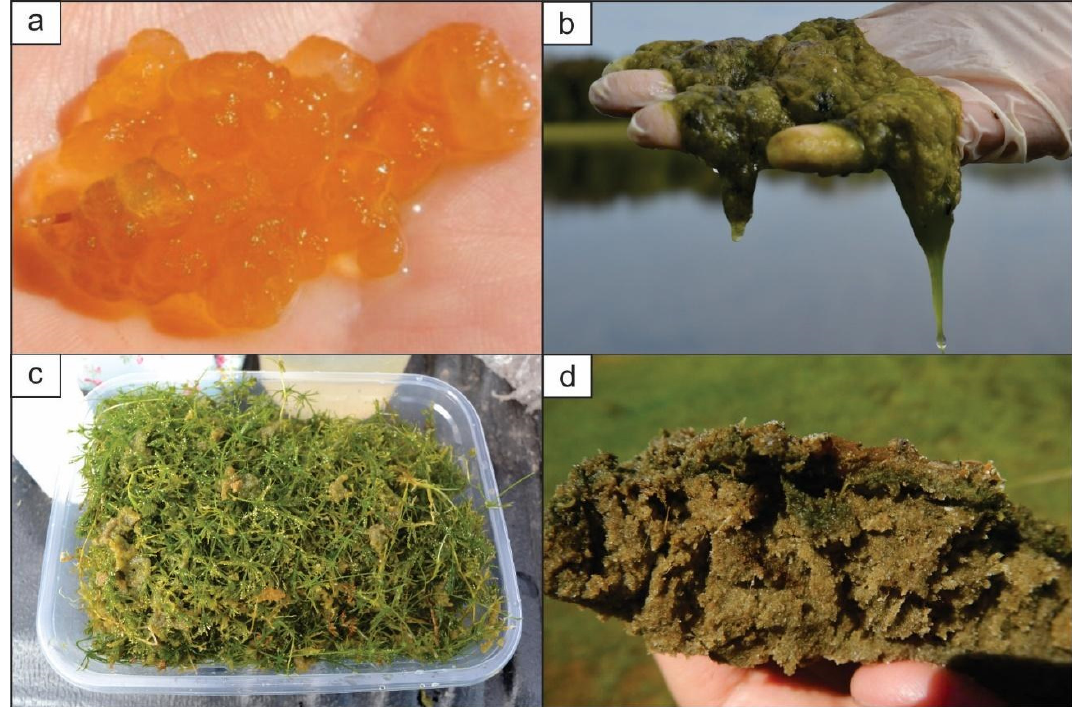
Figure 4. ( a ) Orange bubbles forming the exopolymeric substances (EPS) at Seis Lake, in Nhumirim 2018; ( b ) green viscous EPS at Sete lake, in Barranco Alto in 2017; ( c ) the algae type charophyte observed at Sete B lake in 2017 and ( d ) The sediment crust from Seis lake, with the microbial mat on the top the